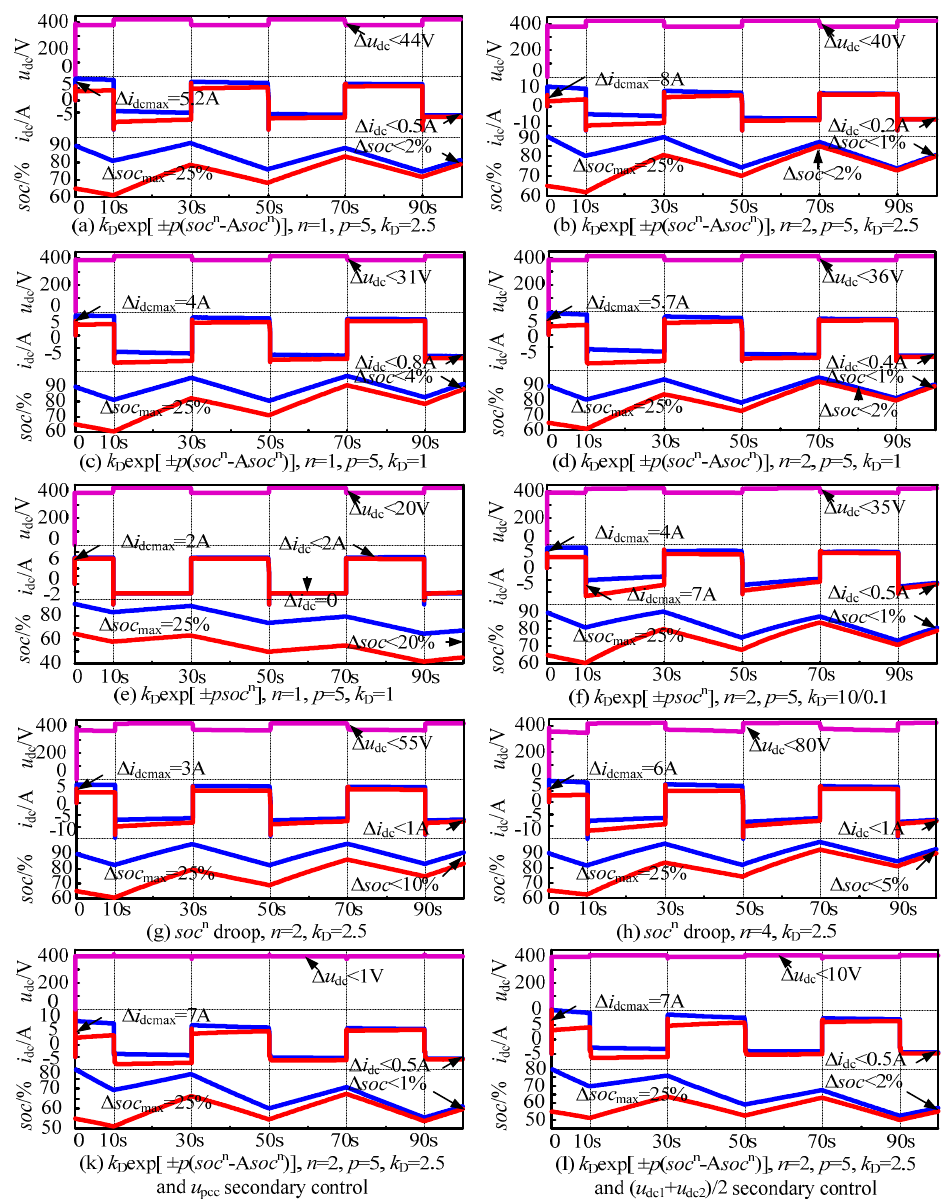
Figure 10. The result of state of charge (SOC) droop control by MATLAB/Simulink. The first and second lithium battery pack capacity 0.5 Ah, linear zone capacity 0.4 Ah, non-linear zone capacity